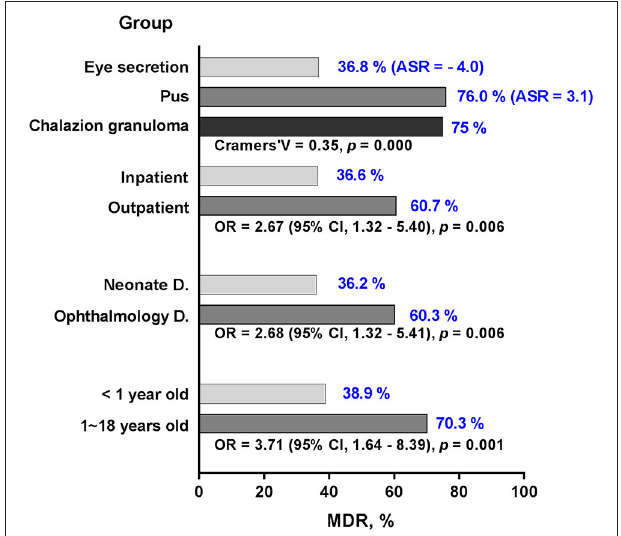
FIGURE 5 | Multidrug resistance percentage of MSSA by different groups. The percentage of MDR (blue numbers) among MSSA are stratified by groups of age, department, inpatient and specimen. With the exception of adjusted standardized residuals applied for specimen, odd ratio and confidence interval are used to demonstrate significant differences in the groups. MDR, multidrug resistance; MSSA, methicillin-sensitive S. aureus ; D., department; ASR, adjusted standardized residuals; OR, odd ratio; CI, confidence interval.